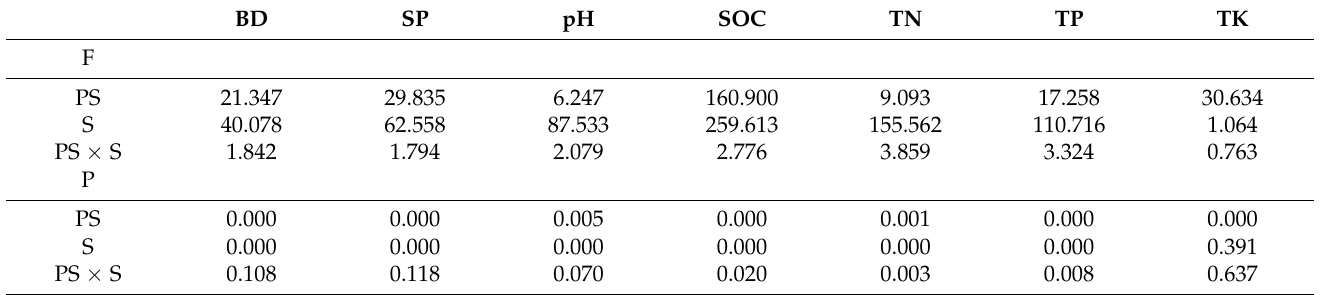
Figure 2. Vertical variations of BD ( a ), soil porosity ( b ) and pH values ( c ) in different land-use types. The different lowercase letters indicate significant differences among planting systems for the same soil layer based on Duncan’s multiple comparison test at p < 0.05. P, poplar plantation system; P–W, wheat field system after deforestation of a poplar plantation; W, wheat field system. Table 1. The analysis of variance of BD, soil porosity, pH, SOC, TN, TP, and TK contents affected by land-use type and soil